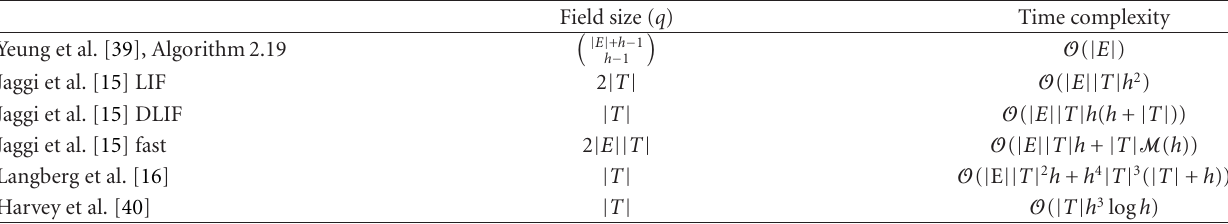
Table 2: Comparison of deterministic algorithms for network code construction. | E | is the total number of edges in the network, | V | the number of nodes, and | T | the number of sinks. M ( h ) is the time required to perform an h × h matrix multiplication. Langberg suggest that the correct running times of the algorithms of Jaggi et al. are di ff erent when the number of edges is small [16]. Field size ( q ) Time complexity Yeung et al. [39],